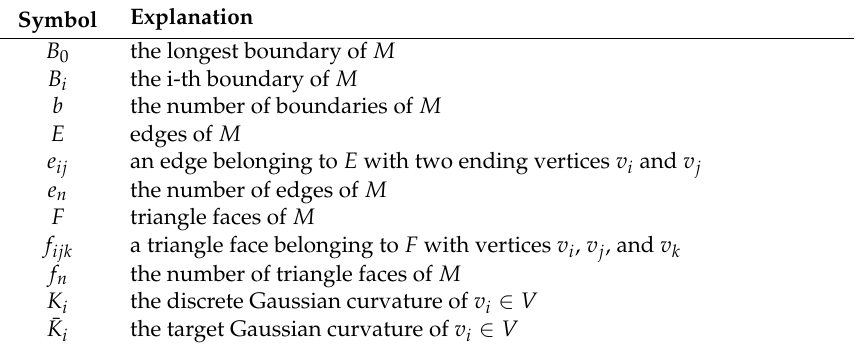
Table 1. Table of